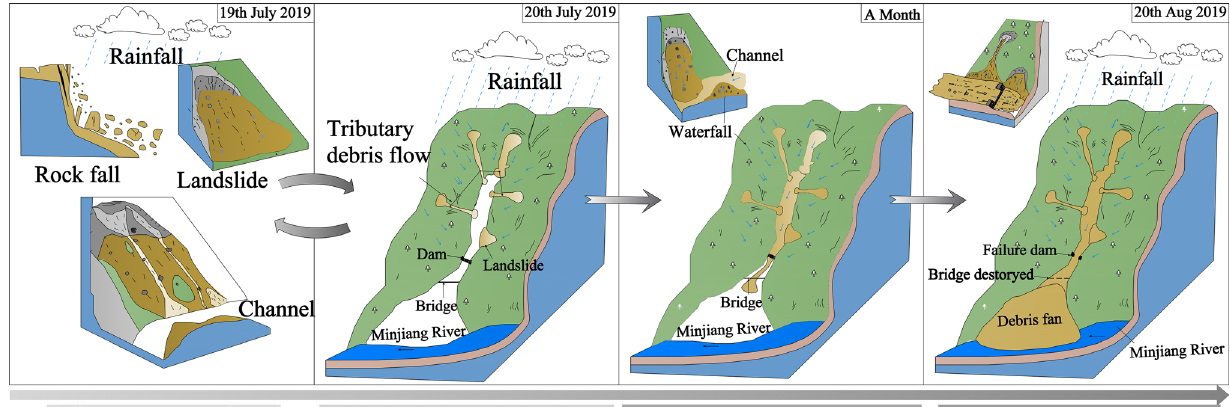
Figure 15. Formation process sketch maps of Chediguan debris flow broken in 20th August. Maps constructed using Coreldraw × 7 (https:// www. corel. com/ cn/).